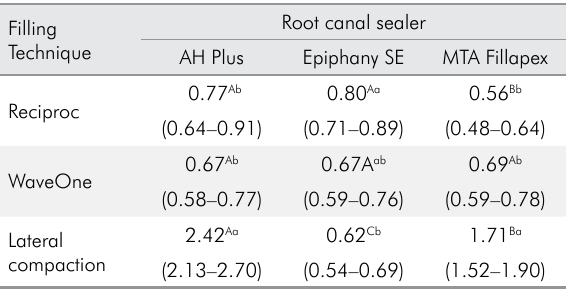
Table 1. Means (95%CI) of bond strength in MPa.